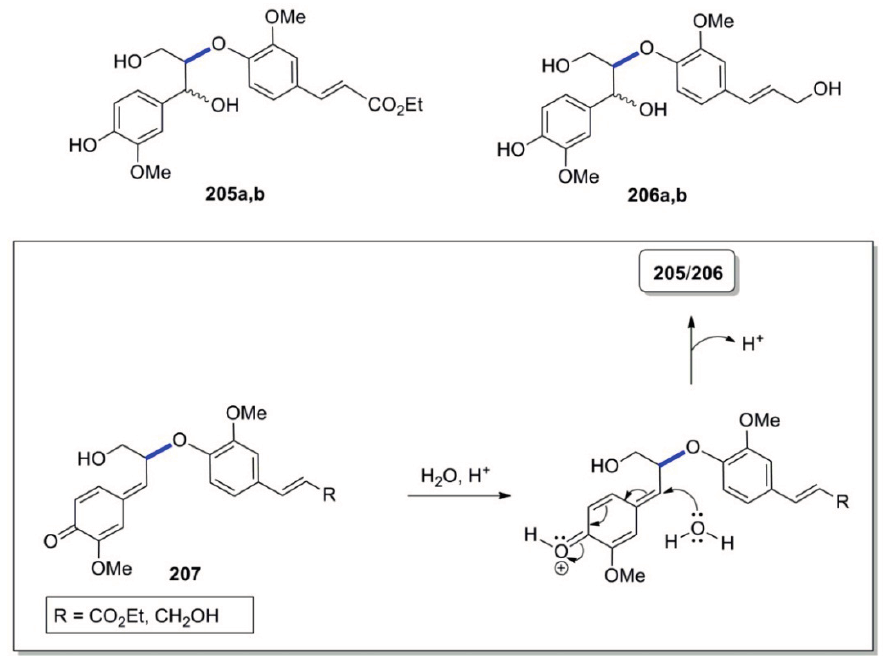
Figure 14. Cross ( 205 )- and homo ( 206 )-coupled products of the β - Ο -4 ether type from the cross-POC of Et-Fer with ConAl and outline of mechanism of their